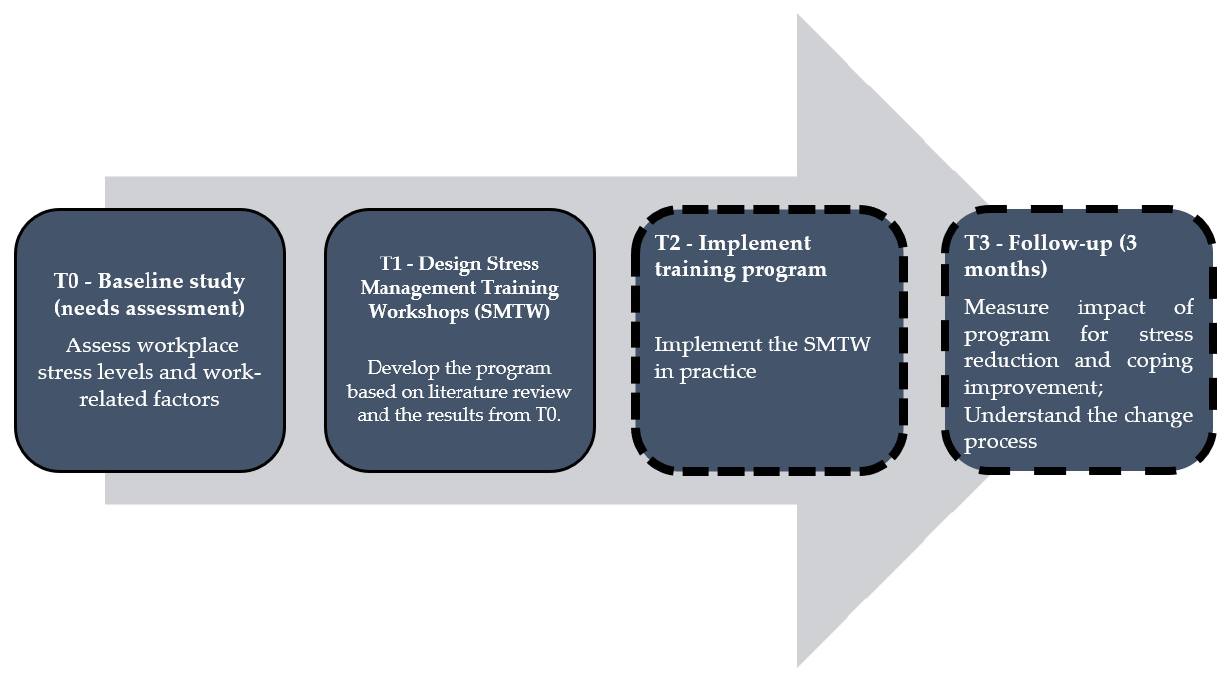
Figure 1. Overview of study phases and objectives .